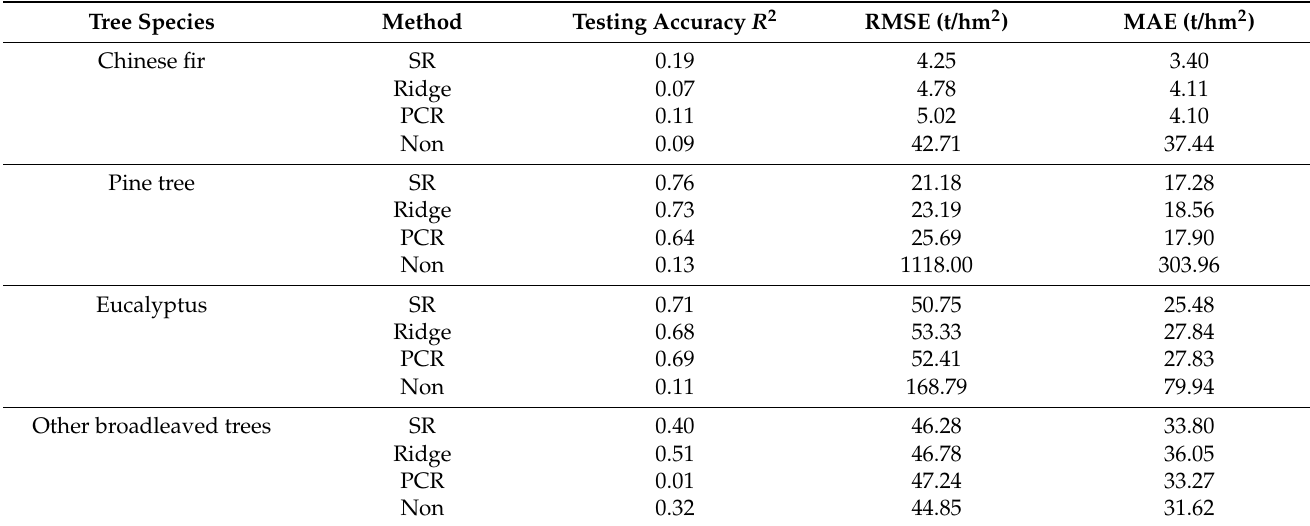
Table 10. Testing